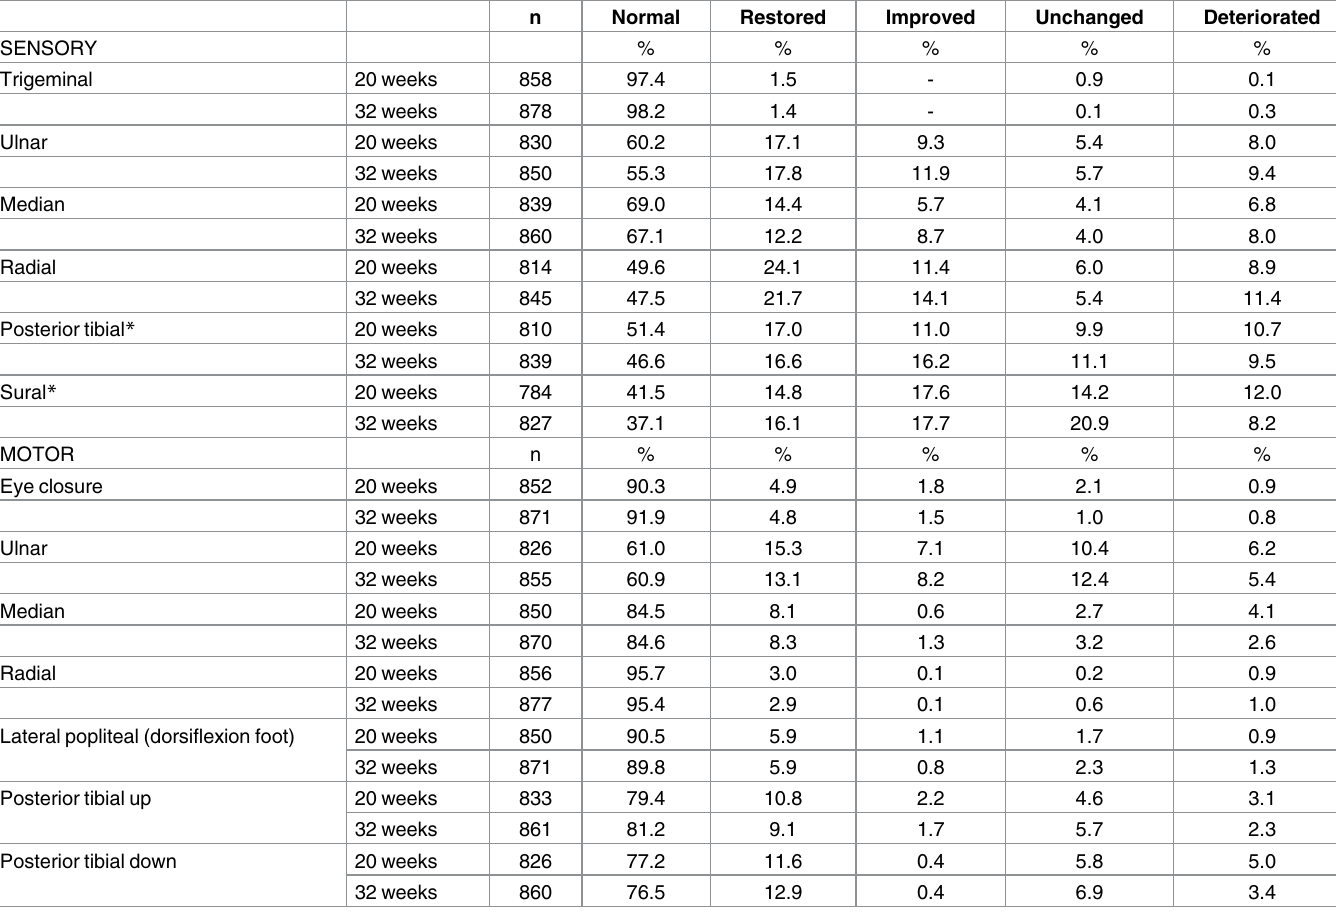
Table 4. Outcomes per nerve at week